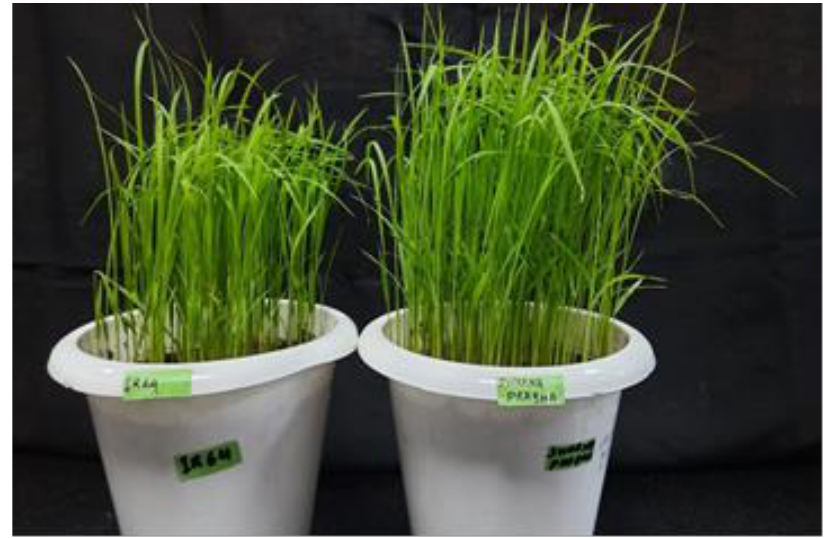
Figure 3. Morphologies ofIR-64 and Swarnaprabha 21-day-old seedlings grown in light-controlled growth